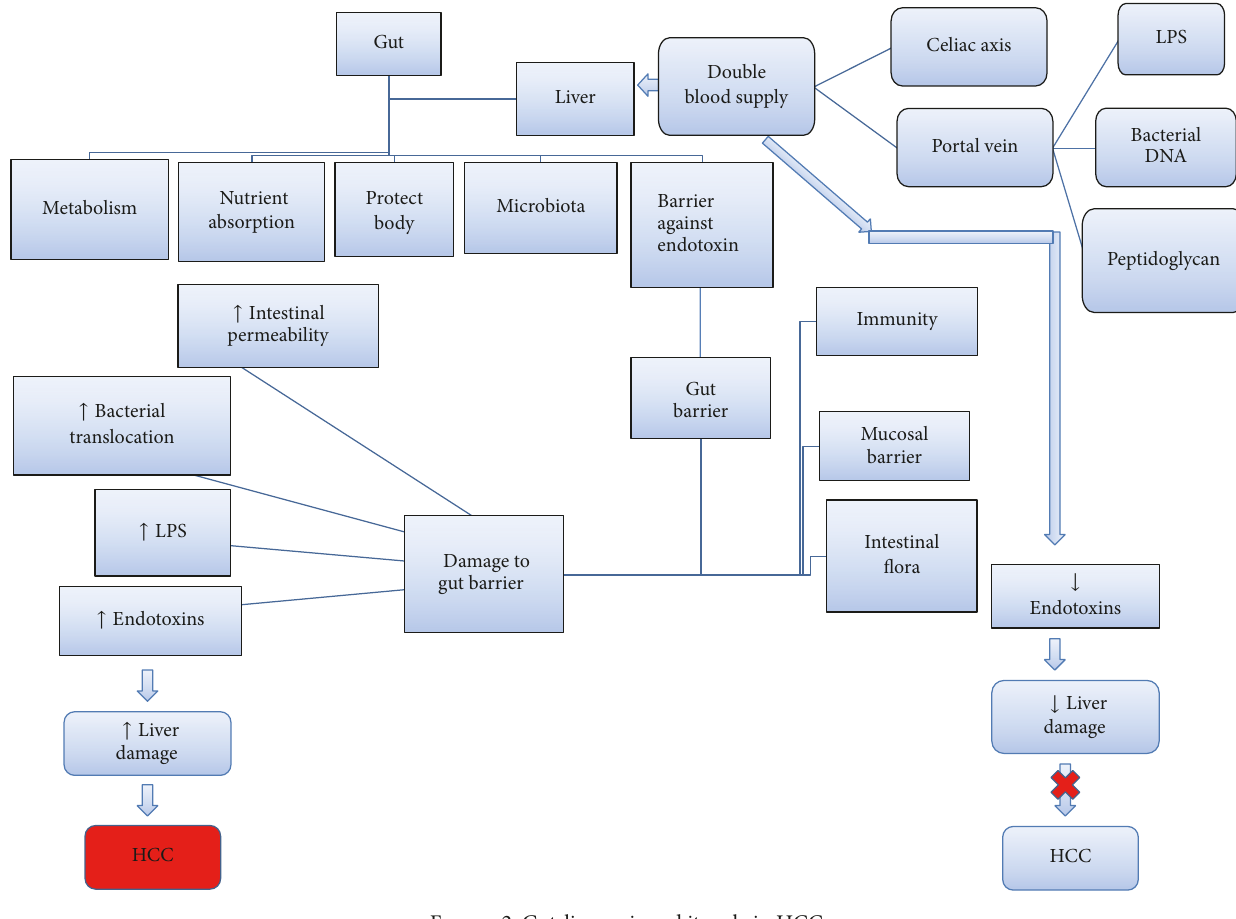
Figure 2: Gut-liver axis and its role in